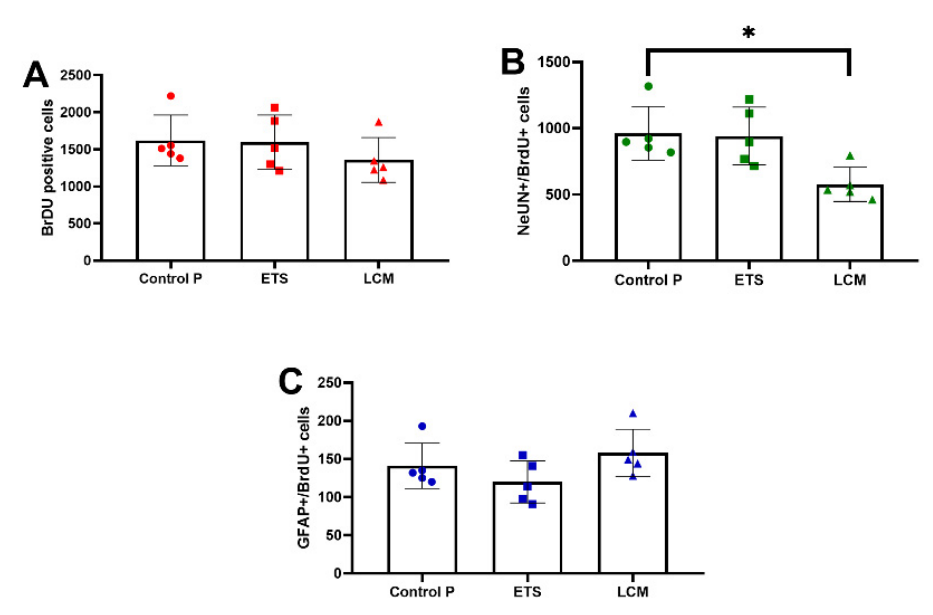
Figure 2. Quantitative analysis of the neurogenesis process after long-term treatment with ETS and LCM in mice after PILO-induced SE. The effect of long-term treatment with ETS and LCM on the total new born cells ( A ), newborn neurons ( B ), and newborn astrocytes ( C ) in the dentate subgranular zone of treated mice. The numbers of cells represent an estimate of the total number of positively labeled cells in the subgranular zone in both hemispheres. The results were analyzed using one-way analysis of variance (ANOVA), followed by Dunnett’s test for multiple comparisons. Each bar represents the mean for five mice; error bars are S.E.M. (* p < 0.05, n = 5)